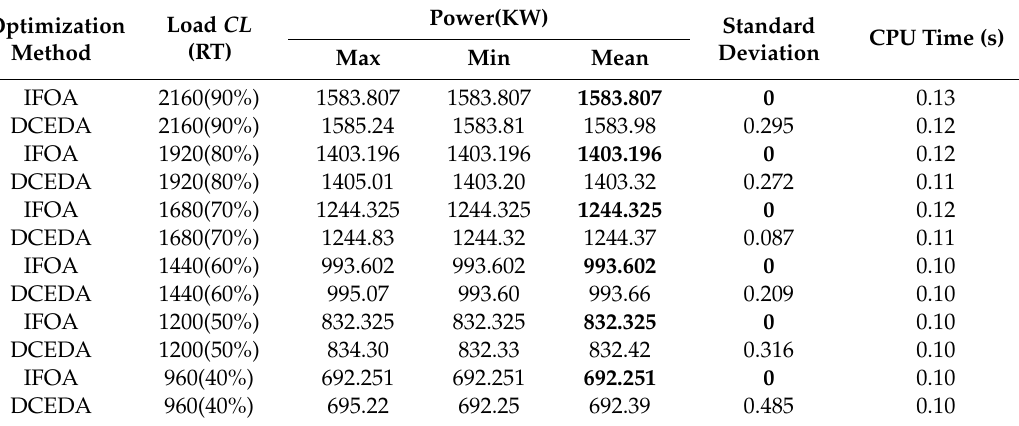
Figure 6. Histogram representation of results in case 3. Table 10. Results of objective function in 30 runs in case